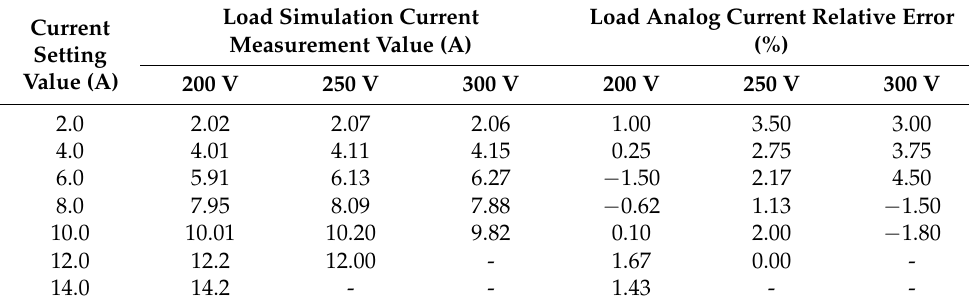
Table 3. Test results of simulation accuracy of constant current